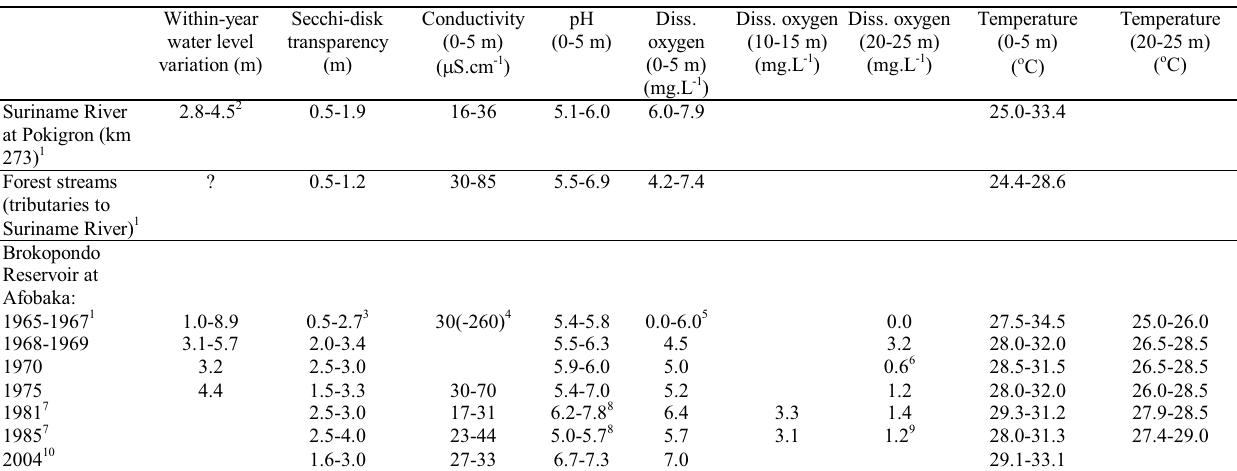
Table 1. Water quality of Suriname River and forest streams in future Brokopondo Reservoir area before closing of the dam in 1964 and Brokopondo Reservoir in the period 1964-present. Data are presented as minimum and maximum values, except for dissolved oxygen concentrations in Brokopondo Reservoir (means). Data sources are Van der Heide (1982) 1 , Hydraulic Research Division (1970; years 1952-1964) 2 , Hydraulic Research Division and Suralco Ltd aluminum company (unpublished) 7 and J. Mol and P. Ouboter (unpublished) 10 . In the period 1965-1967, water transparency increased in the reservoir 3 , dissolved oxygen concentration increased in the epilimnion 5 , and conductivity was low in surface water and high near the reservoir bottom as a result of decomposition of drowned forest vegetation and subsequent release of electrolytes 4 . The hypolimnion oxygen concentration decreased after spraying of water hyacinth with herbicide and subsequent decomposition of dead water plants on reservoir bottom 6 . In the months June-October 1985, hypolimnion water was anoxic 9 . The pH of deep hypolim- nion water (20-25 m) was low (5.5-6.3 in 1981 and 4.3-5.2 in 1985) compared to surface water 8